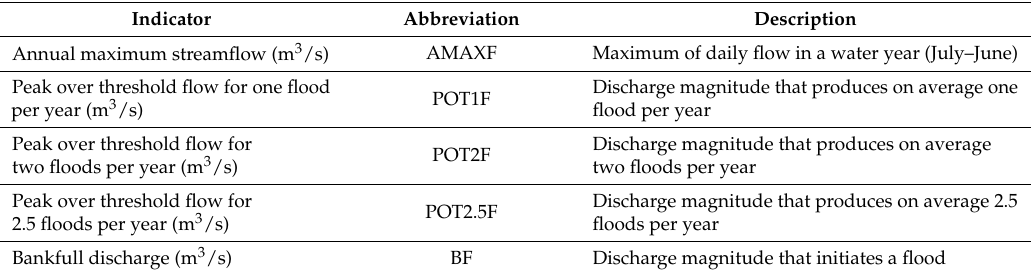
Table 1. List of flood indicators used for frequency analysis for all